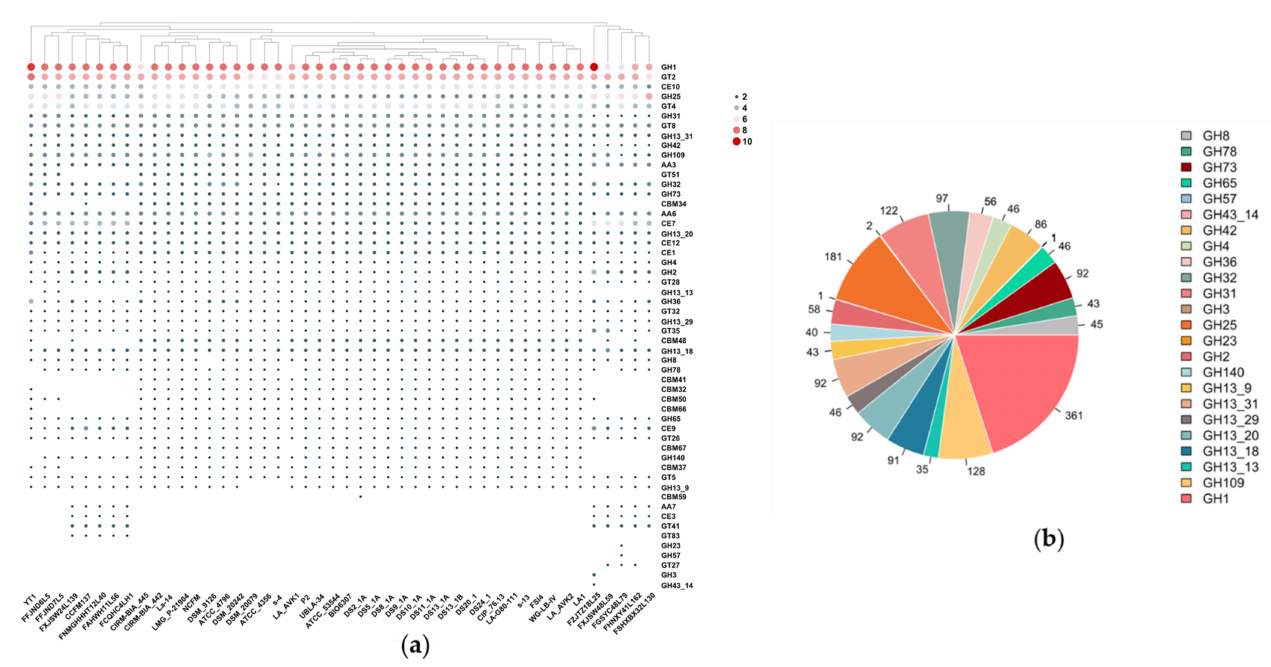
Figure 6. Carbohydrate utilization families identified in L. acidophilus. ( a ) Heatmap showing the distribution of carbohy- drates utilization families. ( b ) Pie chart indicating the number of each GH family